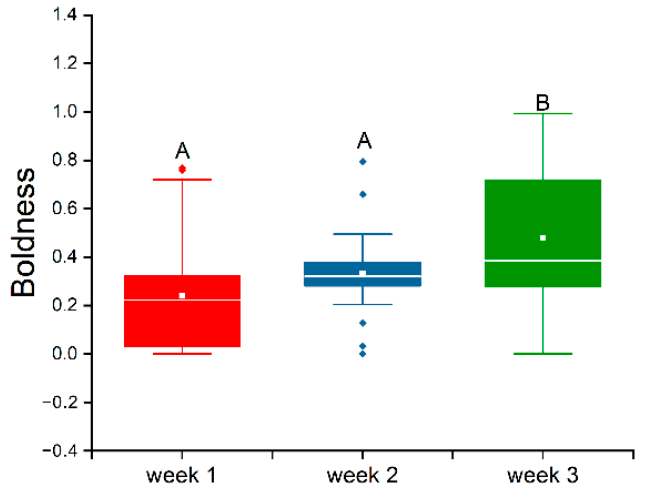
Figure 3. Differences in the results of three repeat boldness tests of swimming crabs. Note: The white line represents the median boldness within the group, and the white rectangle represents the mean boldness within the group. Different capital letters represent significant differences between groups ( p < 0.05). The diamonds represent outliers in the data.